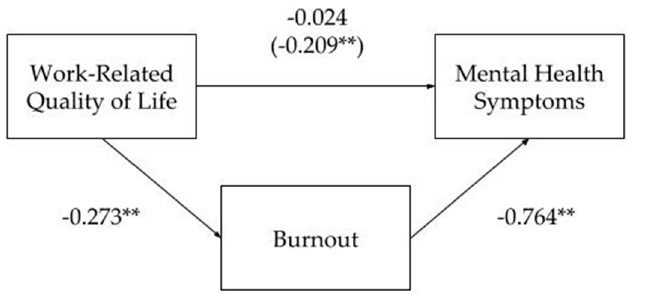
Figure 2. Standardized regression coefficients for the relationship between Work-Related Quality of Life and Mental Health Symptoms as mediated by Burnout. The standardized indirect effect was statistically significant. (** p < 0 .001).